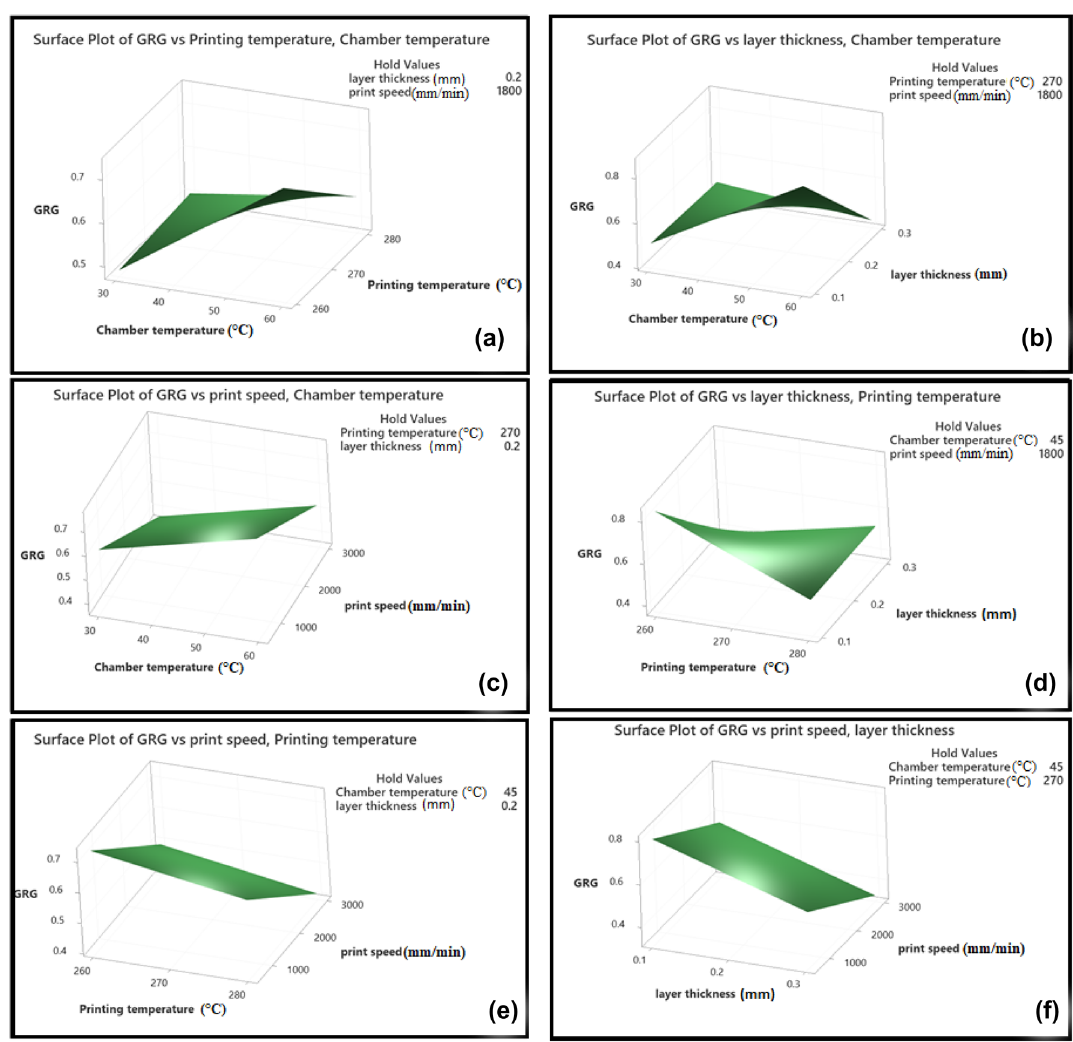
Figure 10. GRG Surface plots. ( a ) chamber temperature and printing temperature, ( b ) chamber temperature and layer thickness, ( c ) chamber temperature and print speed, ( d ) printing temperature and layer thickness, ( e ) printing temperature and print speed, ( f ) layer thickness and print speed, on